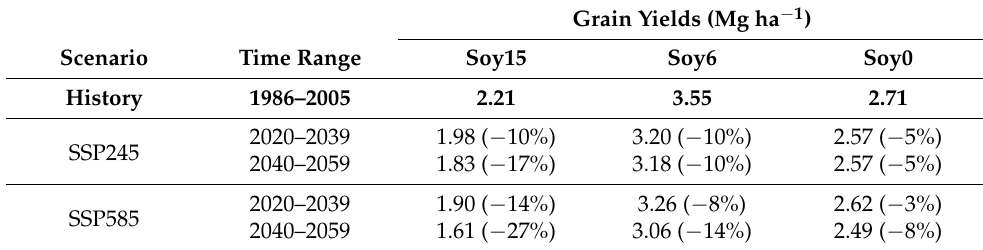
Table 9. ALMANAC simulated yields of three soybean sprout cultivars (Soy15, Soy6, and Soy0) in a historical period (1986–2005) and two future periods (2020–2039 and 2040–2059) under two climate change scenarios (SSP245 and SSP585) (yield loss in percent compared with yield in the historical period is written in